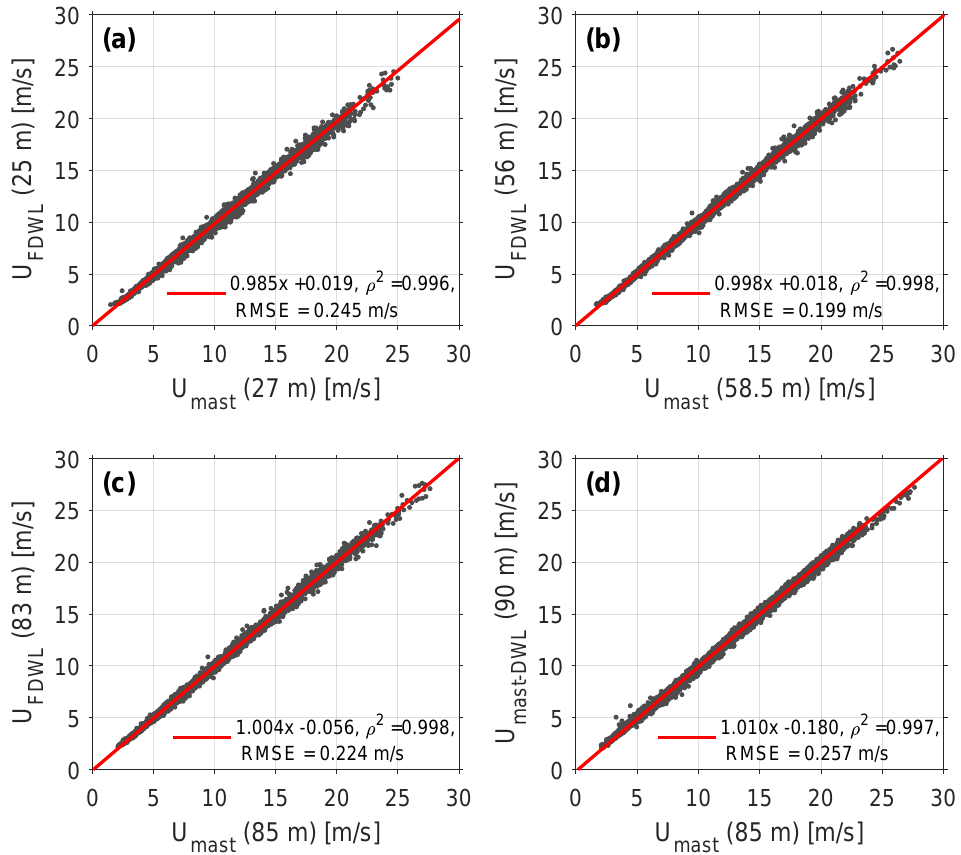
Figure 7. Quality assurance. ( a – c ) Comparison between FDWL HWS (denoted U FDWL ) and cup anemometer HWS ( U mast ) at the at different heights (see labels). ( d ) Same as ( a ) but for the DWL on the mast at 90 m. The red line indicates the regression line. ρ 2 is the coefficient of